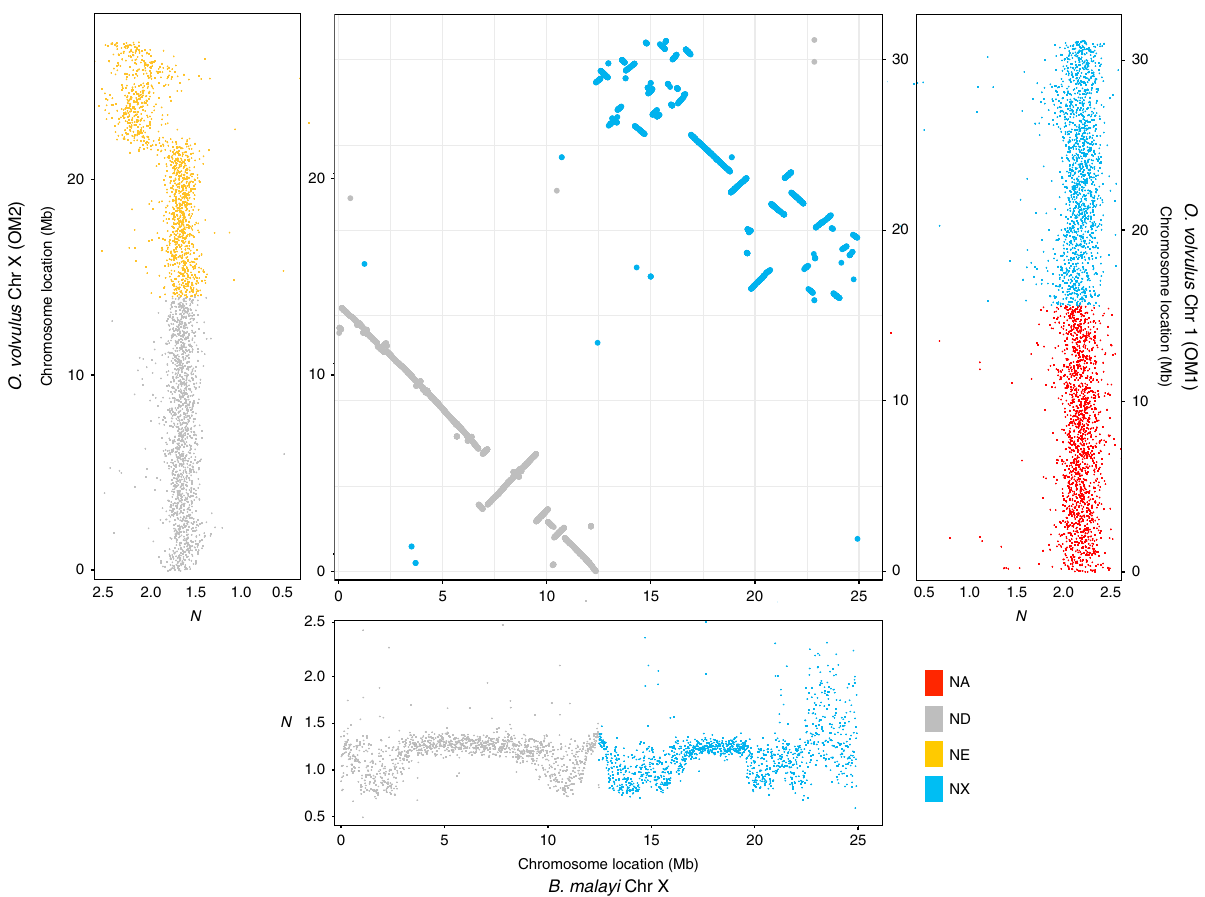
Fig. 2 B. malayi Chr X mapping across O. volvulus Chr 1 (NX) and Chr X (ND). An analysis of the B. malayi X chromosome indicates that it is the product of a fusion of two Nigon elements: ND and NX, in contrast with the O. volvulus X chromosome, which is composed of a fusion between ND and NE. The middle panel, which includes combined mummerplots to highlight Nigon element matches, shows the synteny of the B. malayi X chromosome to its corresponding two Nigon elements in O. volvulus . Each axis is marked with a corresponding sequencing depth plot of that chromosome. Thus, the X -axis of the main plot is linked to the sequencing depth of the Brugia malayi X chromosome, which is divided into ND (gray) and NX (blue). The left Y -axis shows the corresponding O. volvulus chromosome X, composed of ND (gray) and NE (yellow), while the right Y -axis shows the corresponding O. volvulus chromosome 1, composed of NA (red) and NX (blue). In both B. malayi and O. volvulus , ND is fused to a Nigon element that was likely autosomal in the most recent common ancestor, but those fusions occur at opposite ends of ND in the two